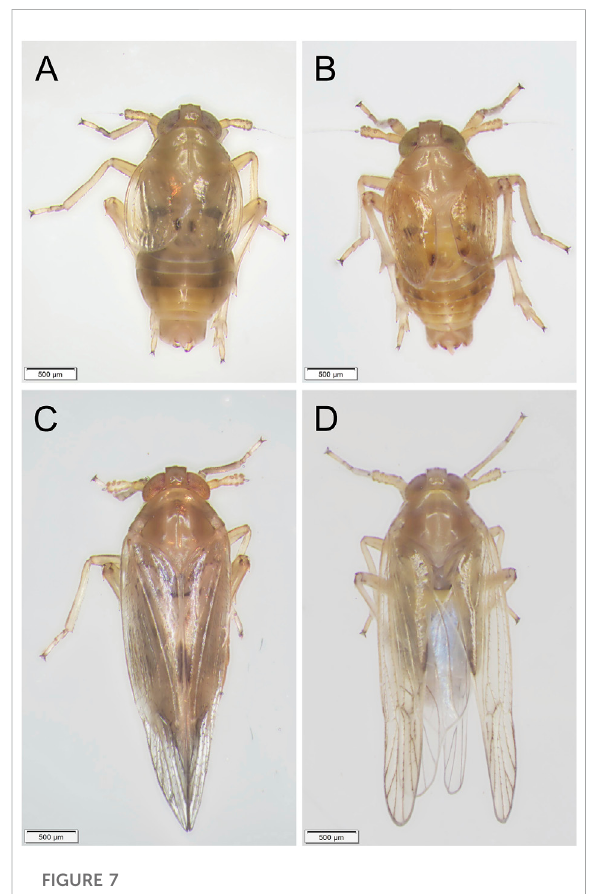
FIGURE 7 Phenotypes of BPH adults developed from nymphs treated with ds Nldelta . (A,B) : Phenotypes of BPH adults of the Brachypterous strain with ds GFP -treatment (A) or ds Nldelta - treatment (B) . (C,D) : Phenotypes of BPH adults of the Macropterous strain with ds GFP -treatment (C) or ds Nldelta - treatment (D) . Third-instar nymphs were injected with 25 ng ds Nldelta . Equivalent ds GFP was used as a